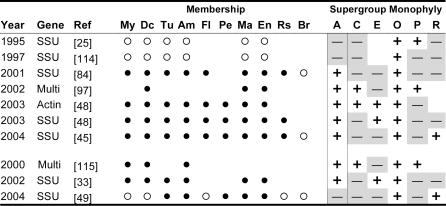
Support for Membership and Supergroup Monophyly from “Amoebozoa”-Targeted Molecular GenealogiesMembership: • indicates the member taxon falls within the supergroup Amoebozoa; ○ indicates that the member taxon is excluded from the Amoebozoa clade, or no clade is formed. Papers below blank line survey eukaryotic diversity [33,49,115] and are included in all analyses. Member taxa: My, Mycetozoa; Dc, Dictyosteliids; Tu, Tubulinea (Lobosea, Gymnamoebea sensu stricto); Am, Acanthamoebidae; Fl, Flabellinea (Discosea, Glycostylea); Pe, Pelomyxa; Ma, Mastigamoebidae; En, Entamoebidae; Rs, residua; Br, Breviata, “Mastigamoeba invertans sensu NCBI.” Supergroup Monophyly, + indicates monophyly; − indicates group is para- or polyphyletic, and blank indicates insufficient data available. Supergroup definition based on Adl et al. 2005 [4]: A, Amoebozoa; C, Chromalveolata; E, Excavata; O, Opisthokonta; P, Plantae; R, Rhizaria. The position of Breviata, Br, was not considered when scoring the monophyly of Amoebozoa as this organism was misidentified and affiliations are unknown (see text). Some nodes were constrained in reference [97]. References cited in this figure are [25,33,45,48,49,84,97,114,115].